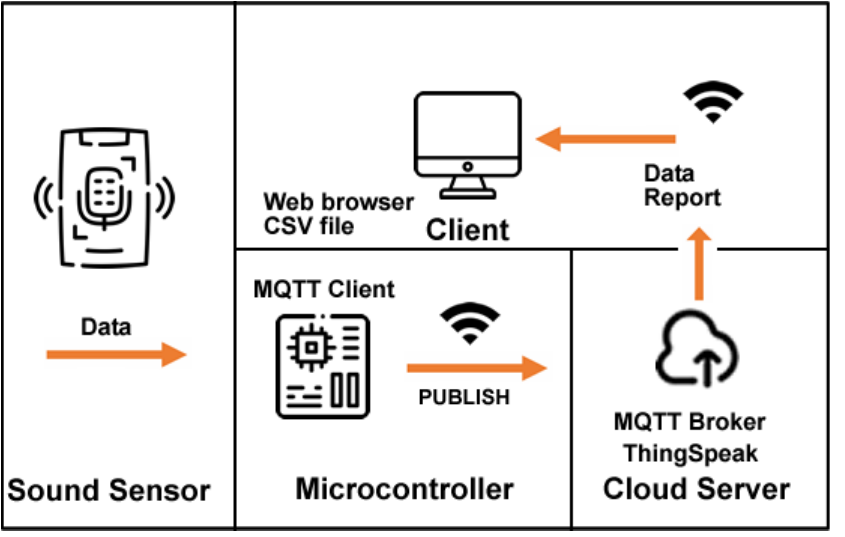
Figure 11. SmartSound System Architecture.